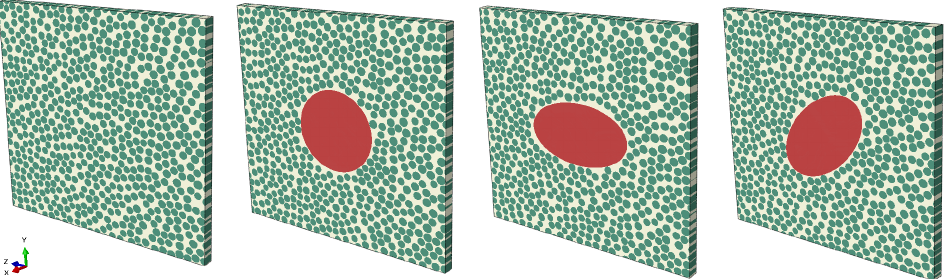
Figure 15. Illustrating the FE RVE models with no void or circular or elliptical voids.